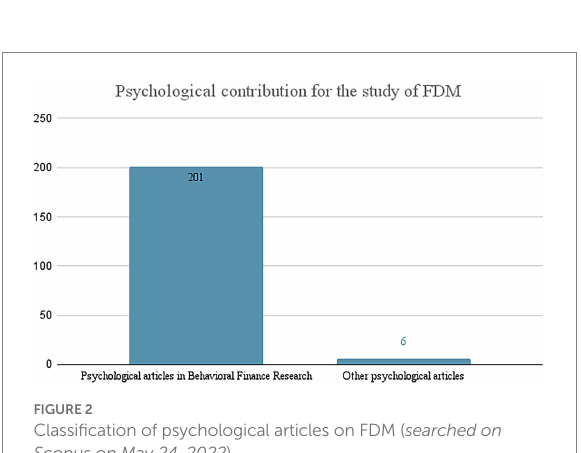
FIGURE 2 Classification of psychological articles on FDM ( searched on Scopus on May 24 , 2022